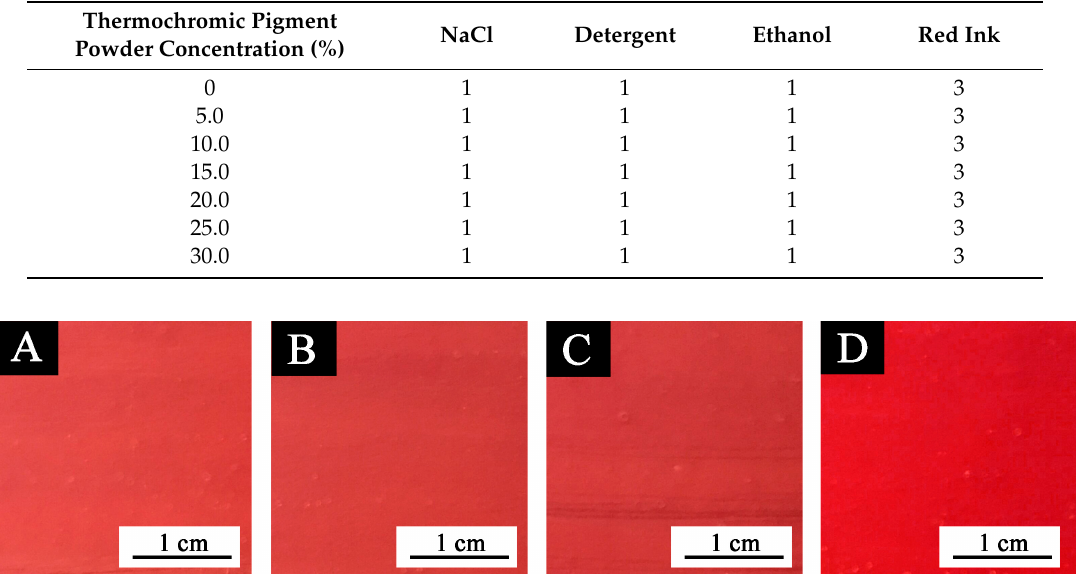
Table 9. The liquid resistance grade of primer film with the different color-changing powder concentration.